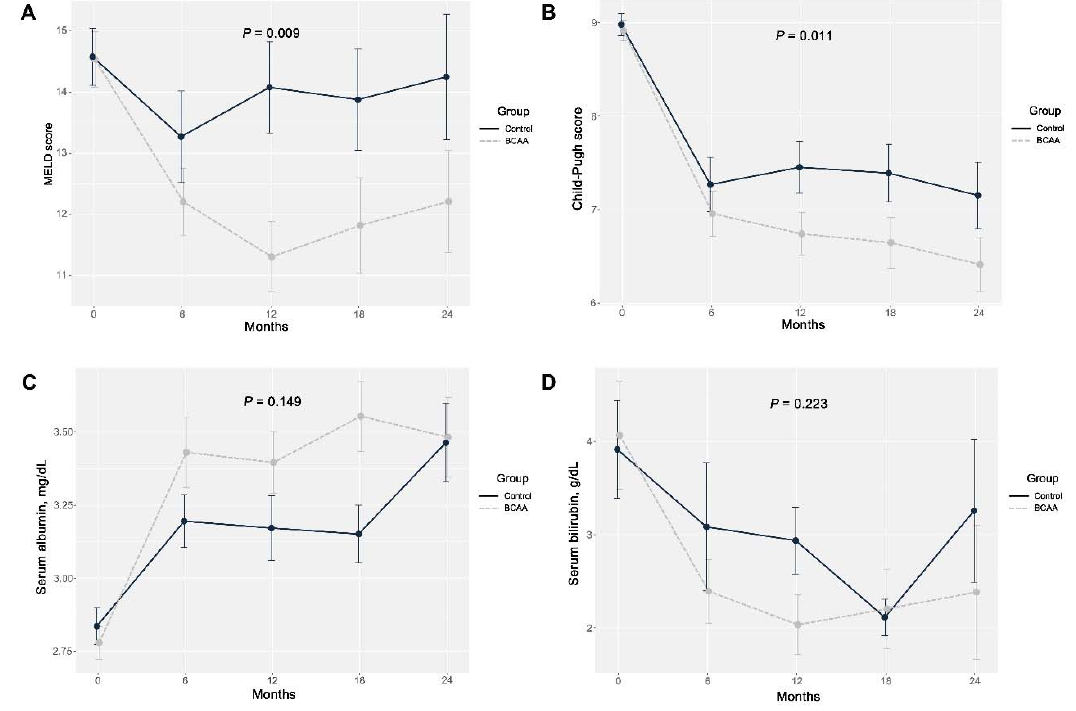
Figure 3. Changes in the model for end-stage liver disease score ( A ), Child–Pugh score ( B ), serum albumin ( C ), and total bilirubin ( D ) in the BCAA and control groups over 2 years. MELD, model for end-stage liver disease; BCAA, branched-chain amino acid.